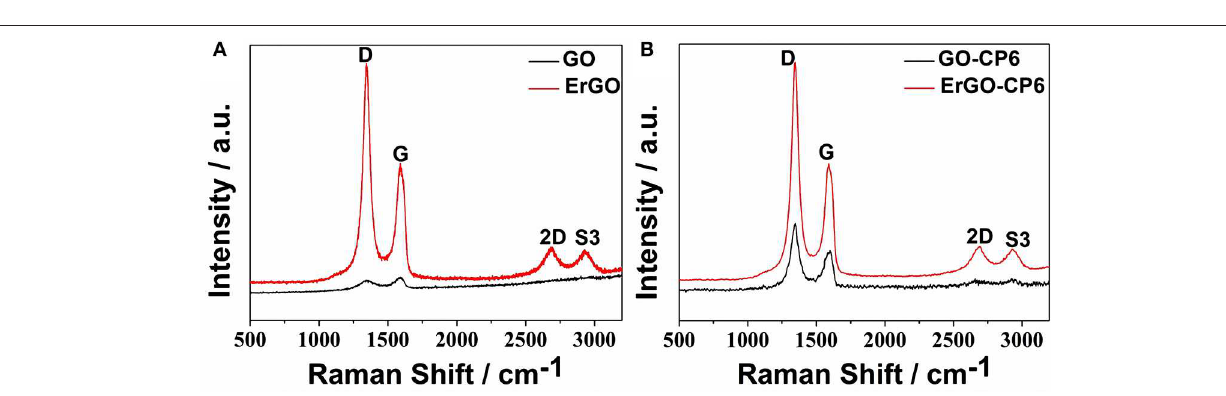
Frontiers in Chemistry |